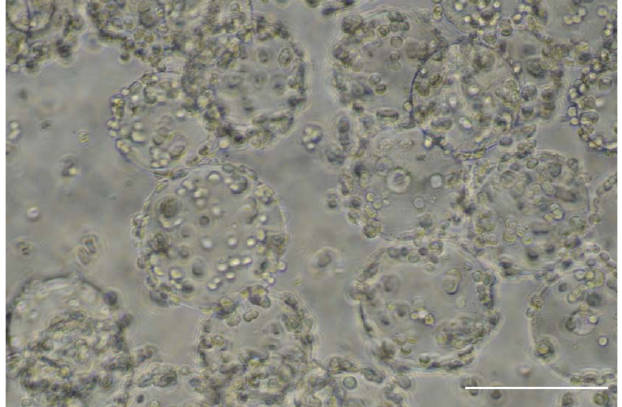
Figure 11. Image of the cell-loaded microcarriers taken at the exit of the static mixer of the continuous microcarrier inoculation process as depicted in Figure 10; the scale bar represents 200 µm.